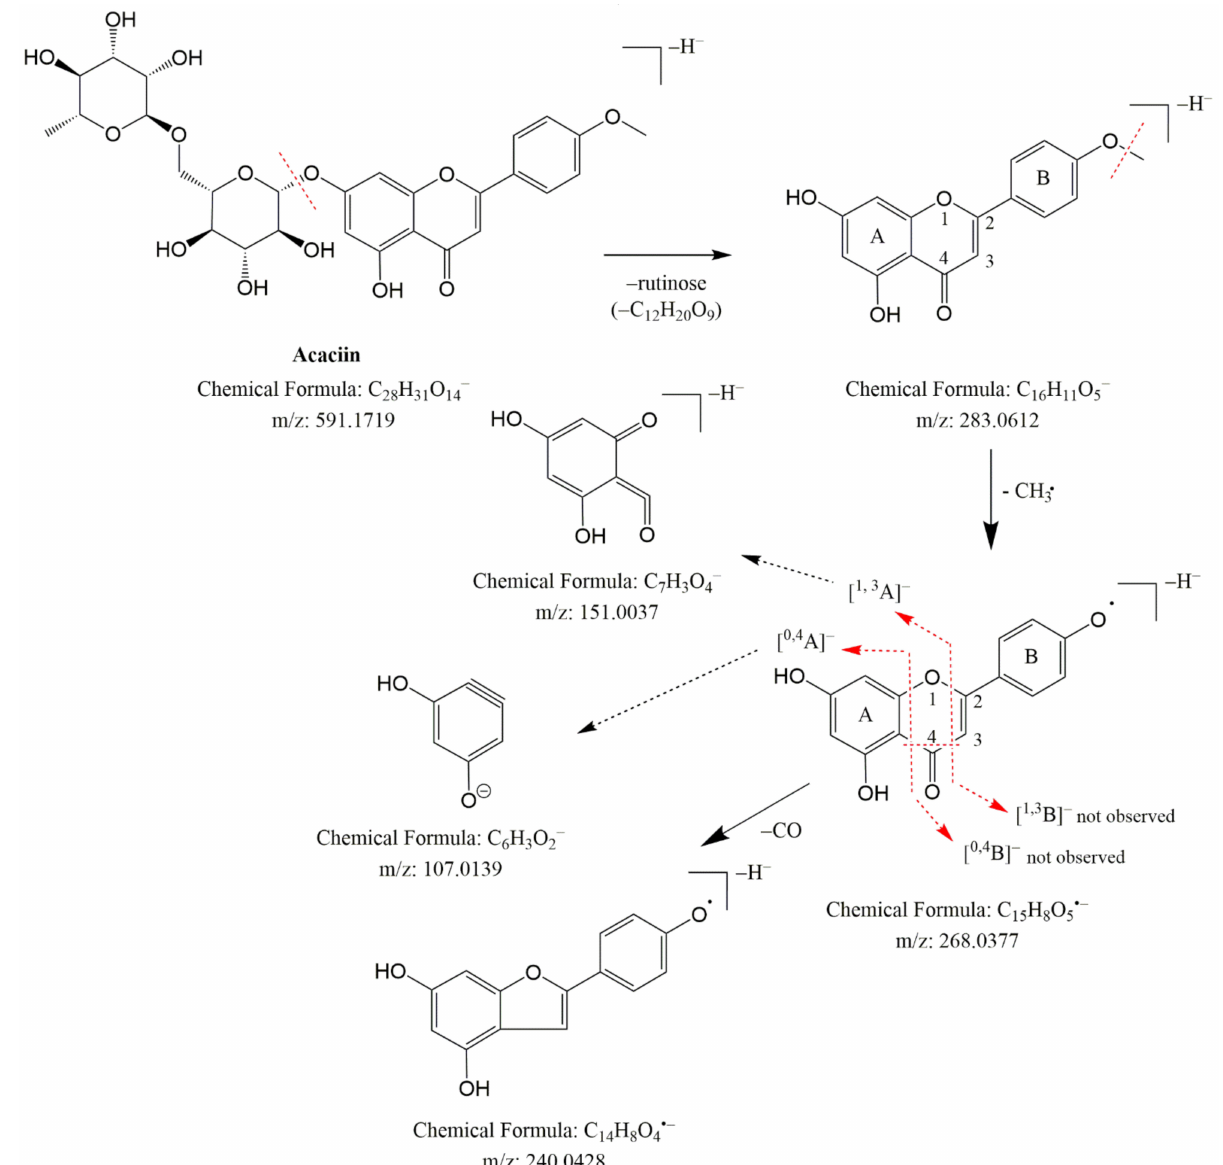
Figure 3. Fragmentation pathway of acaciin